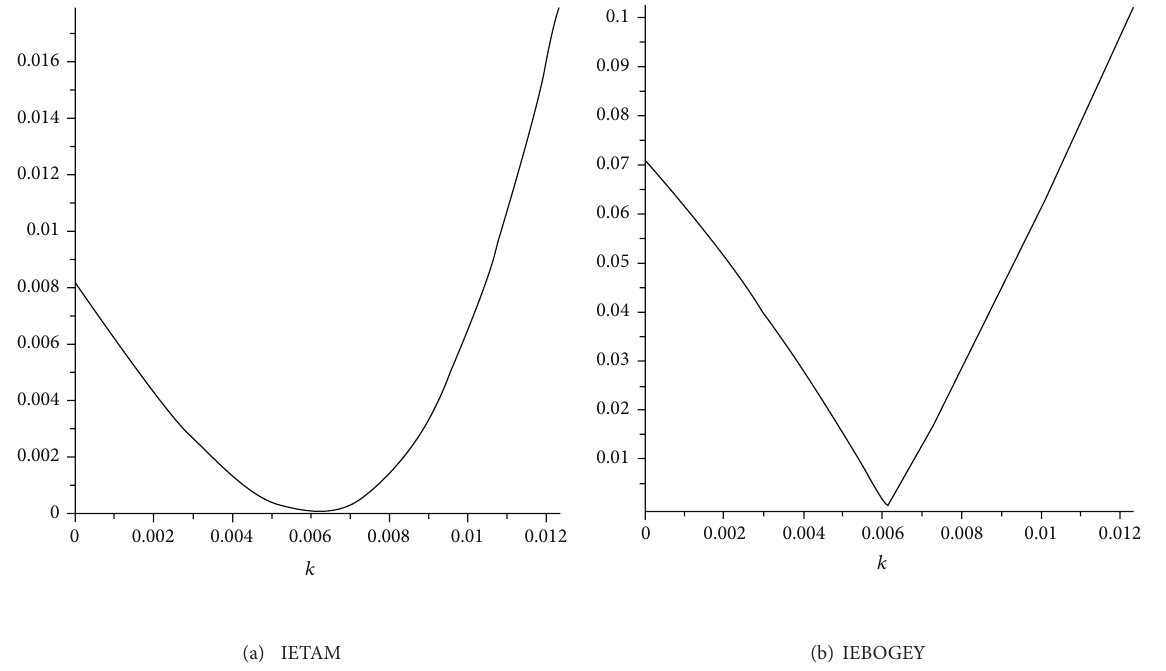
Figure 9: Plots of IETAM versus 𝑘 and EBOGEY versus 𝑘 for the Lax-Wendroff scheme when ℎ = 0.02 .